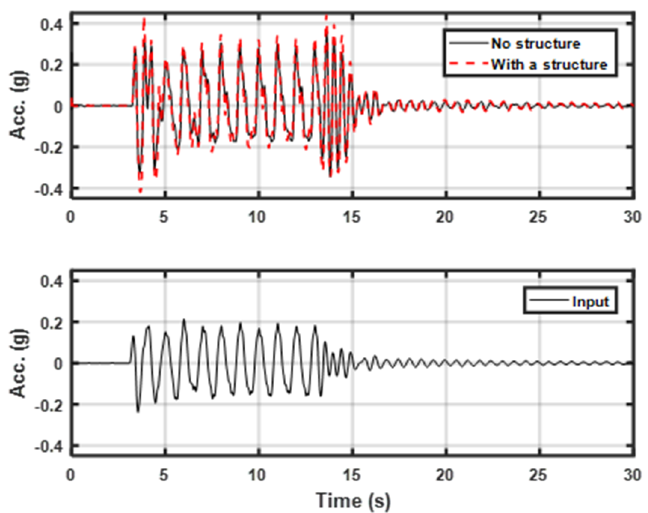
Figure 8. Wall top accelerations.